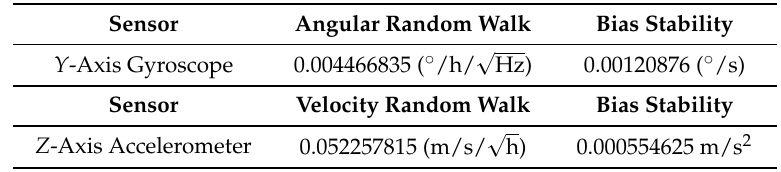
Table 2. Results of Allan variance analysis.